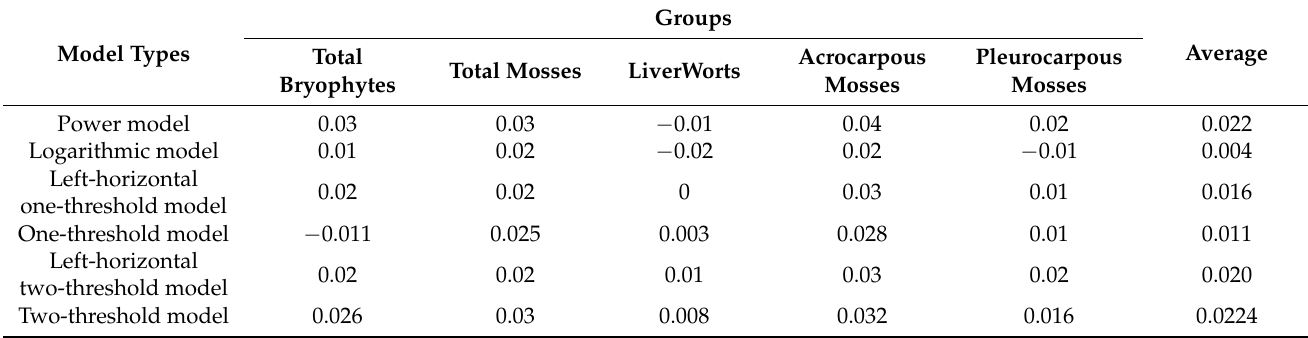
Table 2. The differences of the adjusted r 2 values in SKRs minus those in SARs.